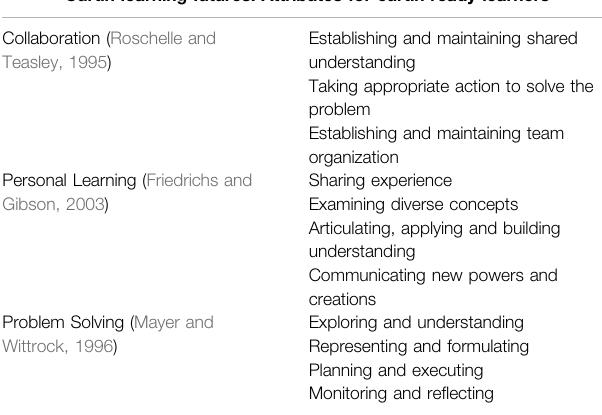
TABLE 1 | The 3 categories of attributes extracted from the Curtin Learning Futures for the keyword framework.